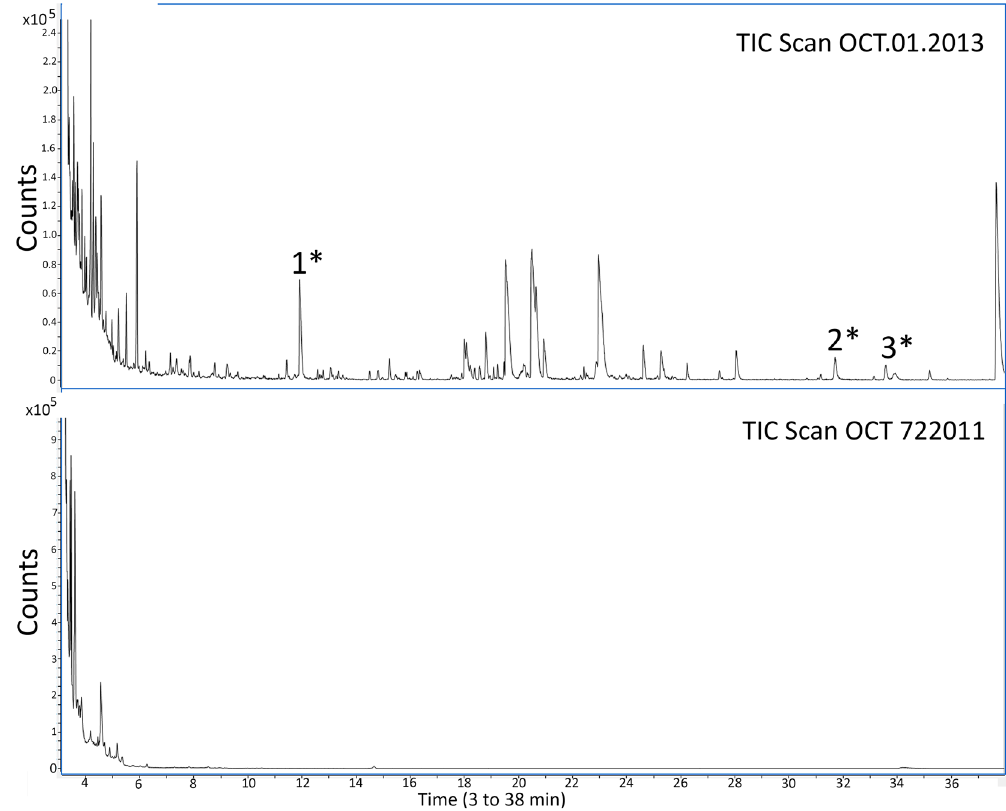
Figure 4. MEROCTANE samples total ion chromatograms (TIC) of from 3 to 38 min (Agilent Mass Hunter qualitative analysis B.07.00). PFO batch OCT 722011 was distributed and used in Spain, no acute toxic cases were reported. PFO batch OCT.01.2013 was distributed in Chile causing acute toxicity in patients. (1) 1,1,1,2,2,3,3,4,4,5,5,6,6-Tridecafluorotridecane,